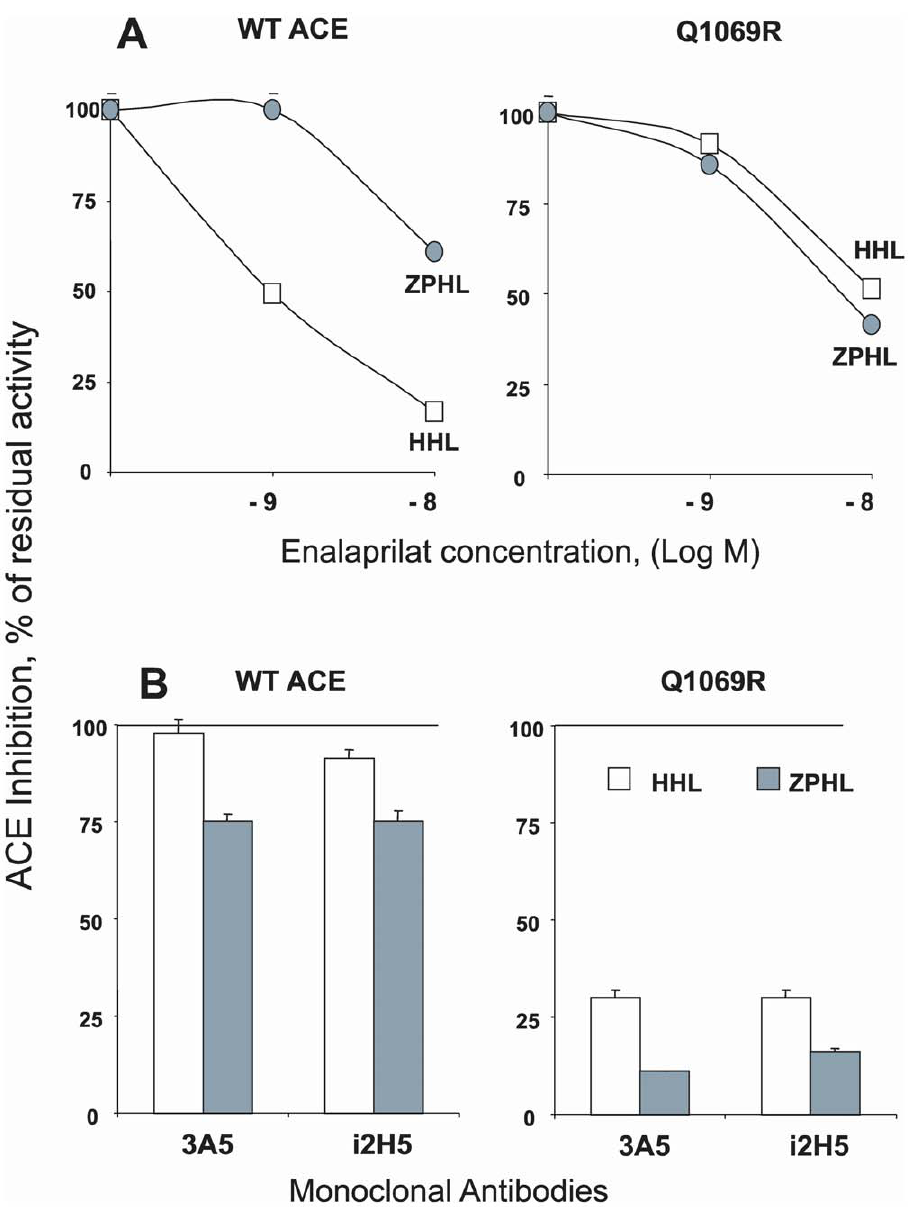
Figure 8. Effect of ACE inhibitors and anti-catalytic mAbs on mutant ACE activity. Lysates form CHO cells expressing mutant and WT membrane-bound ACE were incubated with ACE inhibitor enalaprilat (10 2 9 –10 2 8 M) ( A ) and with mAbs (10 m g/ml) ( B ) which are anti-catalytic for the N-domain active center (i2H5 and 3A5- [30,33]. Residual ACE activity was determined as in Fig. 5.